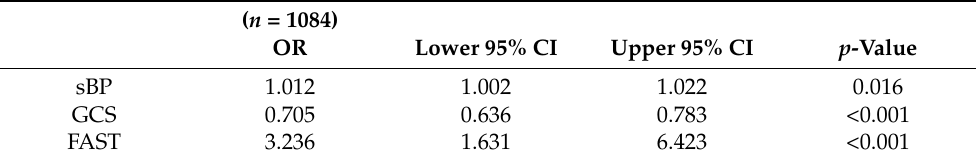
Table 6. Results of multivariate analyses for influencing severity injury of the age group of <15 years with severe injuries. OR: odds ratio, 95%; CI: 95% confidence interval. ( n = 1084)